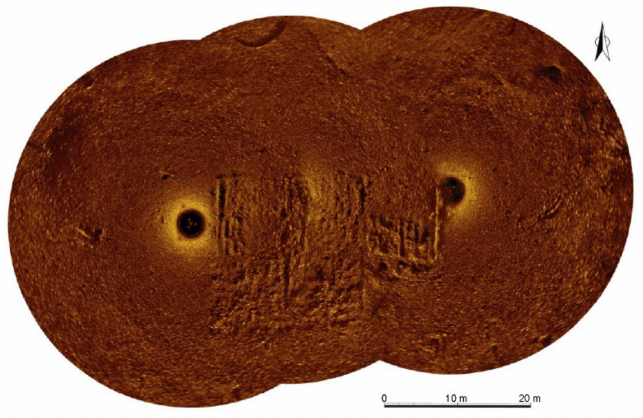
Figure 6. Mosaic scanning sonar image (frequency: 675 kHz; swath: 25 m) of the sediment removal area of the second underwater excavation at the Dangampo